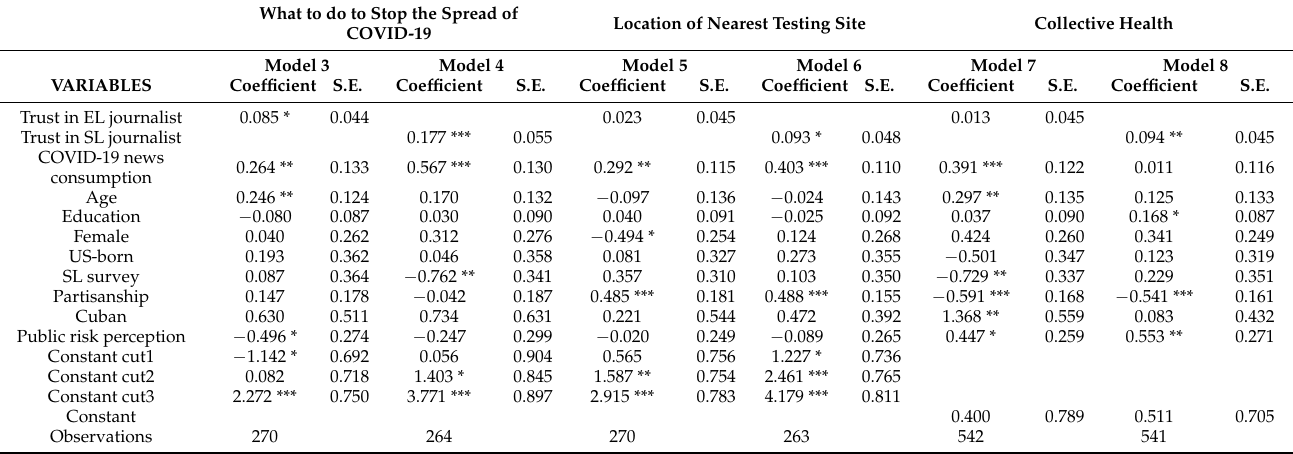
Table 2. Models on attitudes towards information provided by state and local officials and collective health.